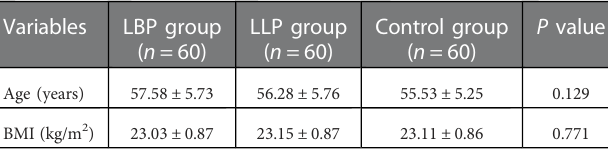
TABLE 1 Comparison of baseline data among the three groups. Variables